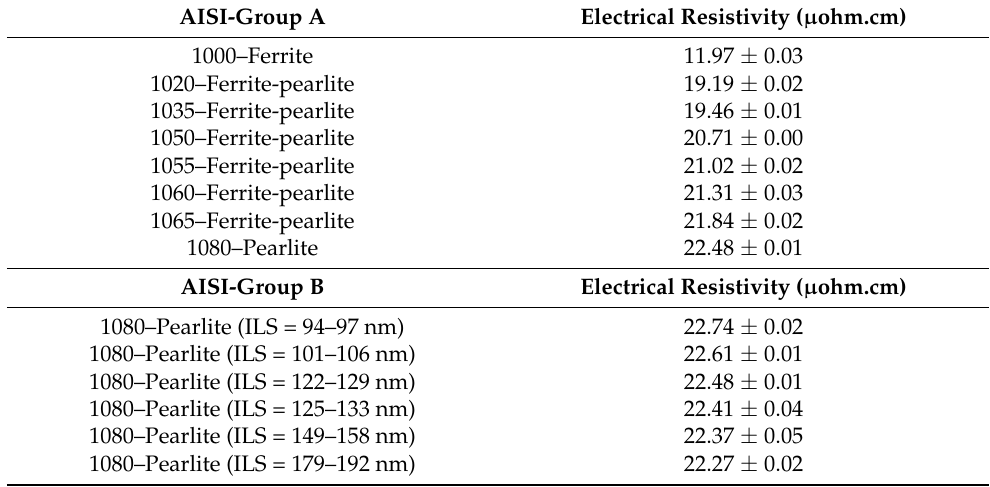
Table 3. Electrical resistivity measurements of samples of groups A and B carried out at 35 ◦ C.